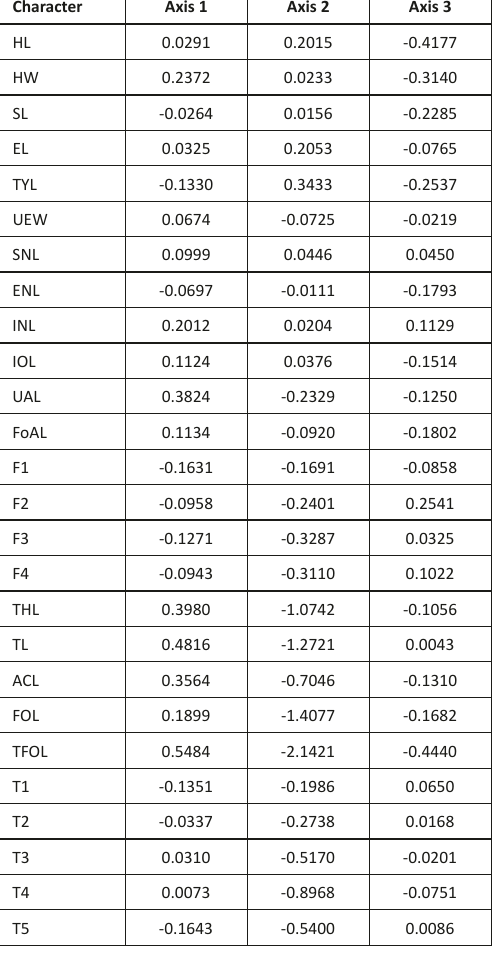
Table 3. Measurements (in mm) of buccal structures in Indirana salelkari and I. chiravasi males. Small letters in parenthesis refer to distances indicated in Figure